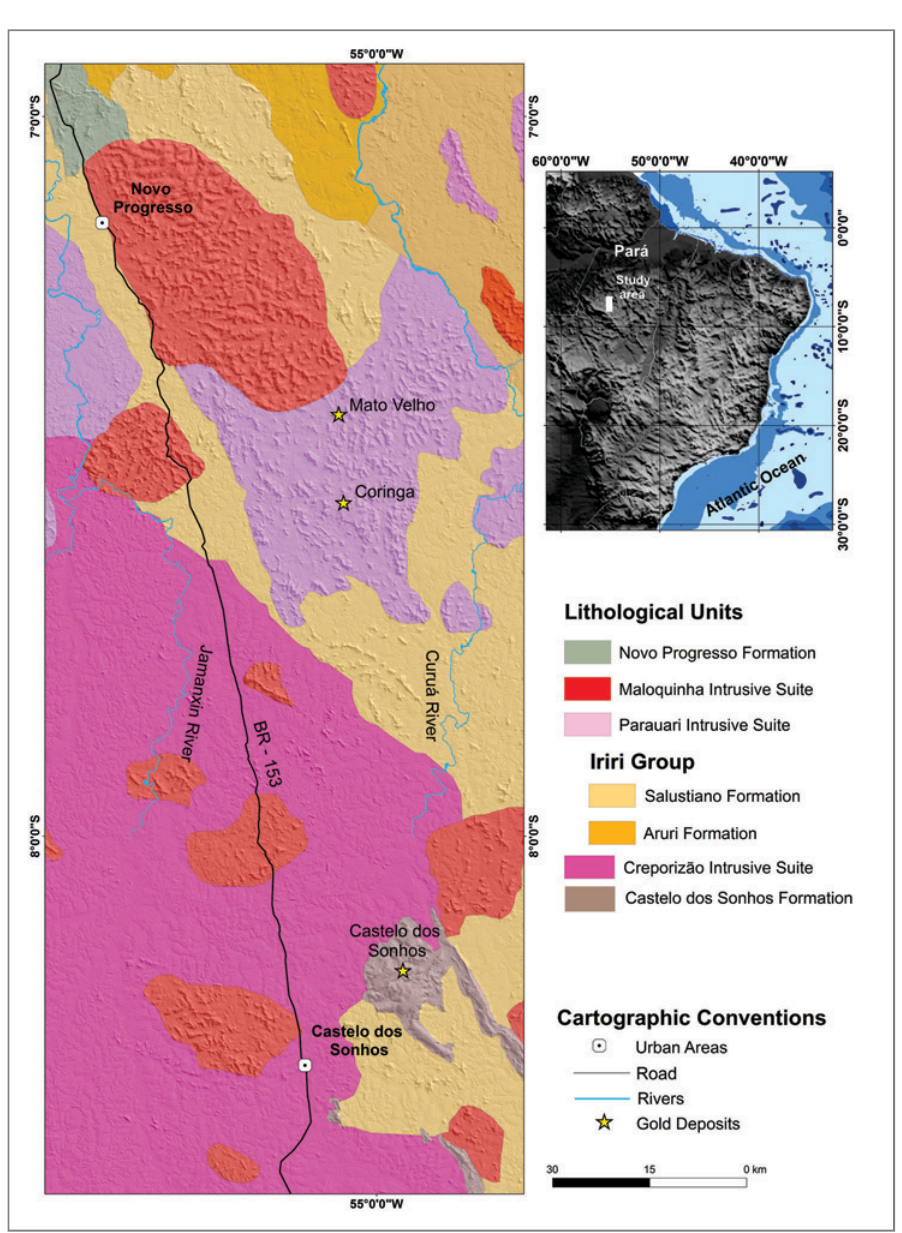
Figure 2 - Geological map of Southeast Tapajós Gold Province (modified from Vasquez and Rosa- Costa